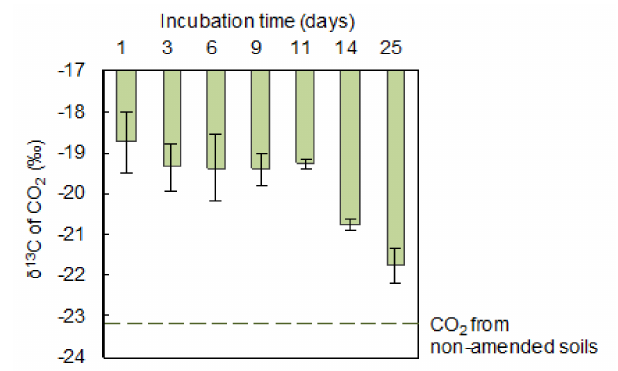
Figure 2. The δ 13 C values of respired CO 2 in the litter-amended Gangcha (GC) soils after the first extreme precipitation event (EPE). Mean values are shown with standard error ( n =